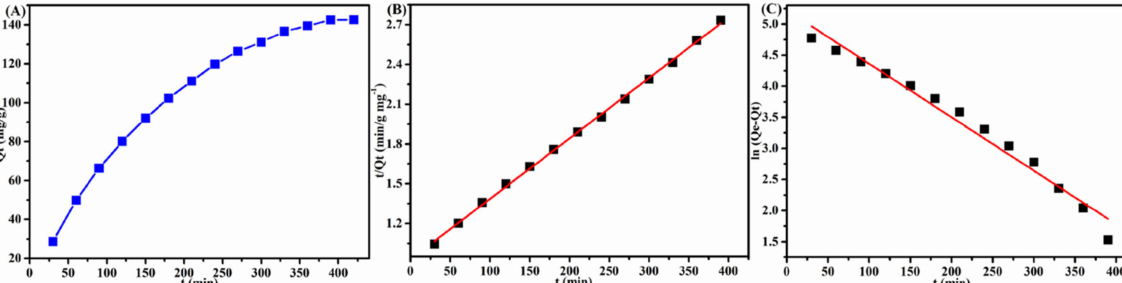
Figure 10. ( A ) Curves displaying Ce(III) absorption on magnetic PMMA-PGMA-PEI; Simulated plots of pseudo-first order ( B ); and pseudo-second order ( C ) models. (Adsorbed dose = 80 kGy, dose rate = 20 kGy/pass, GMA concentration = 40 wt%, dose = 1.0 g/L, contact time = 24 h, pH = 6, C 0 = 200 mg/L, T = 298.15